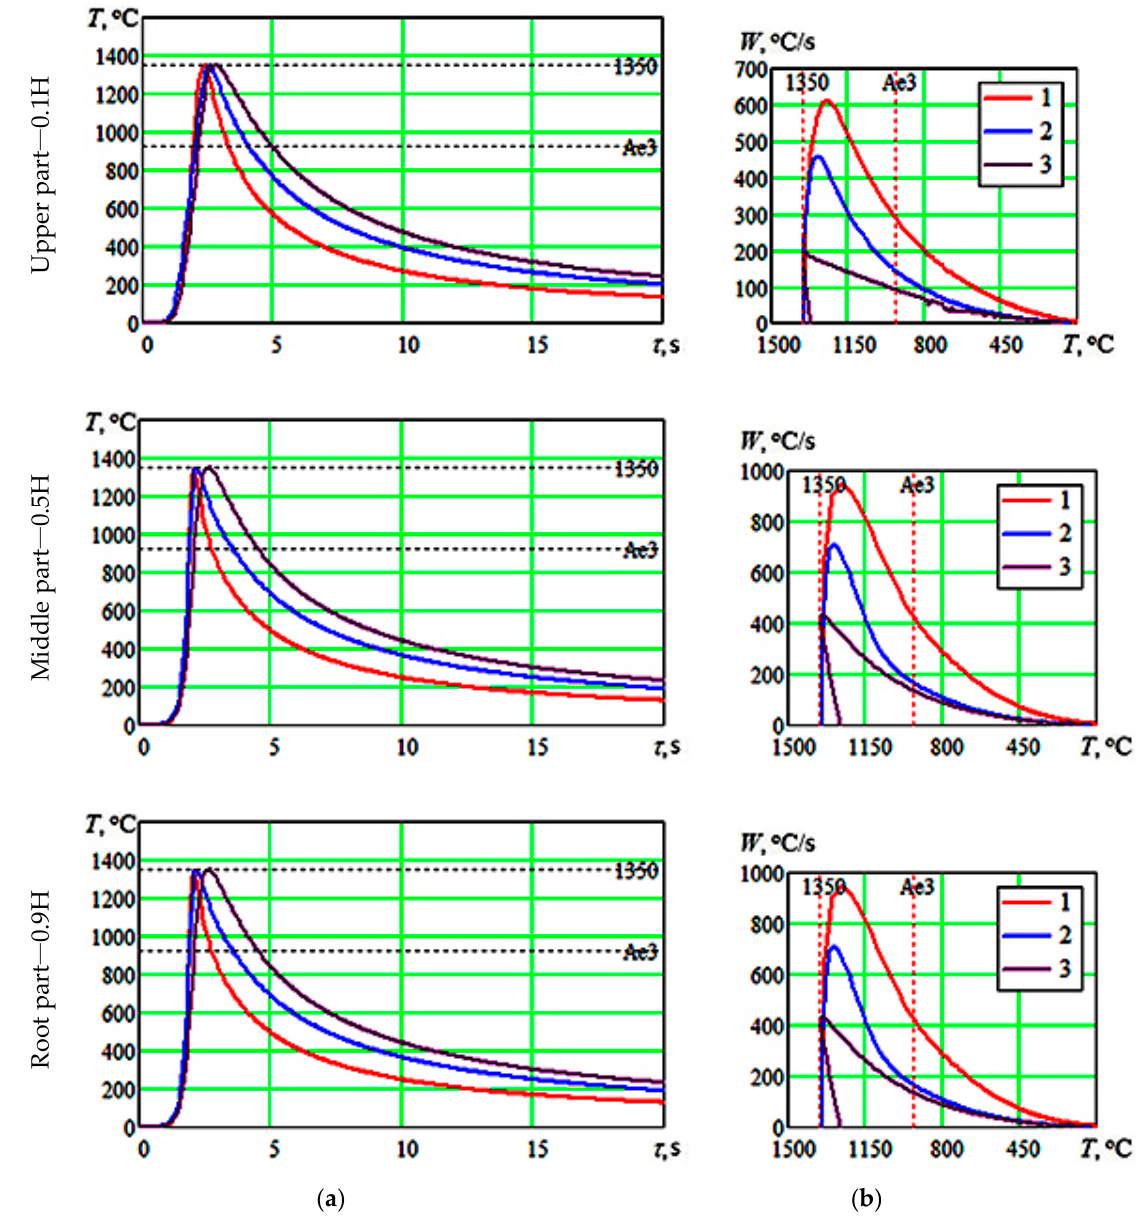
Figure 6. Calculated thermal cycles ( a ) and instantaneous cooling rates ( b ) in the TEZ overheating area (maximum heating temperature—1350 °C) for different weld depths: 1—welding without beam sweep; 2—welding with x-shaped beam oscillations; 3—welding with combined beam sweep.